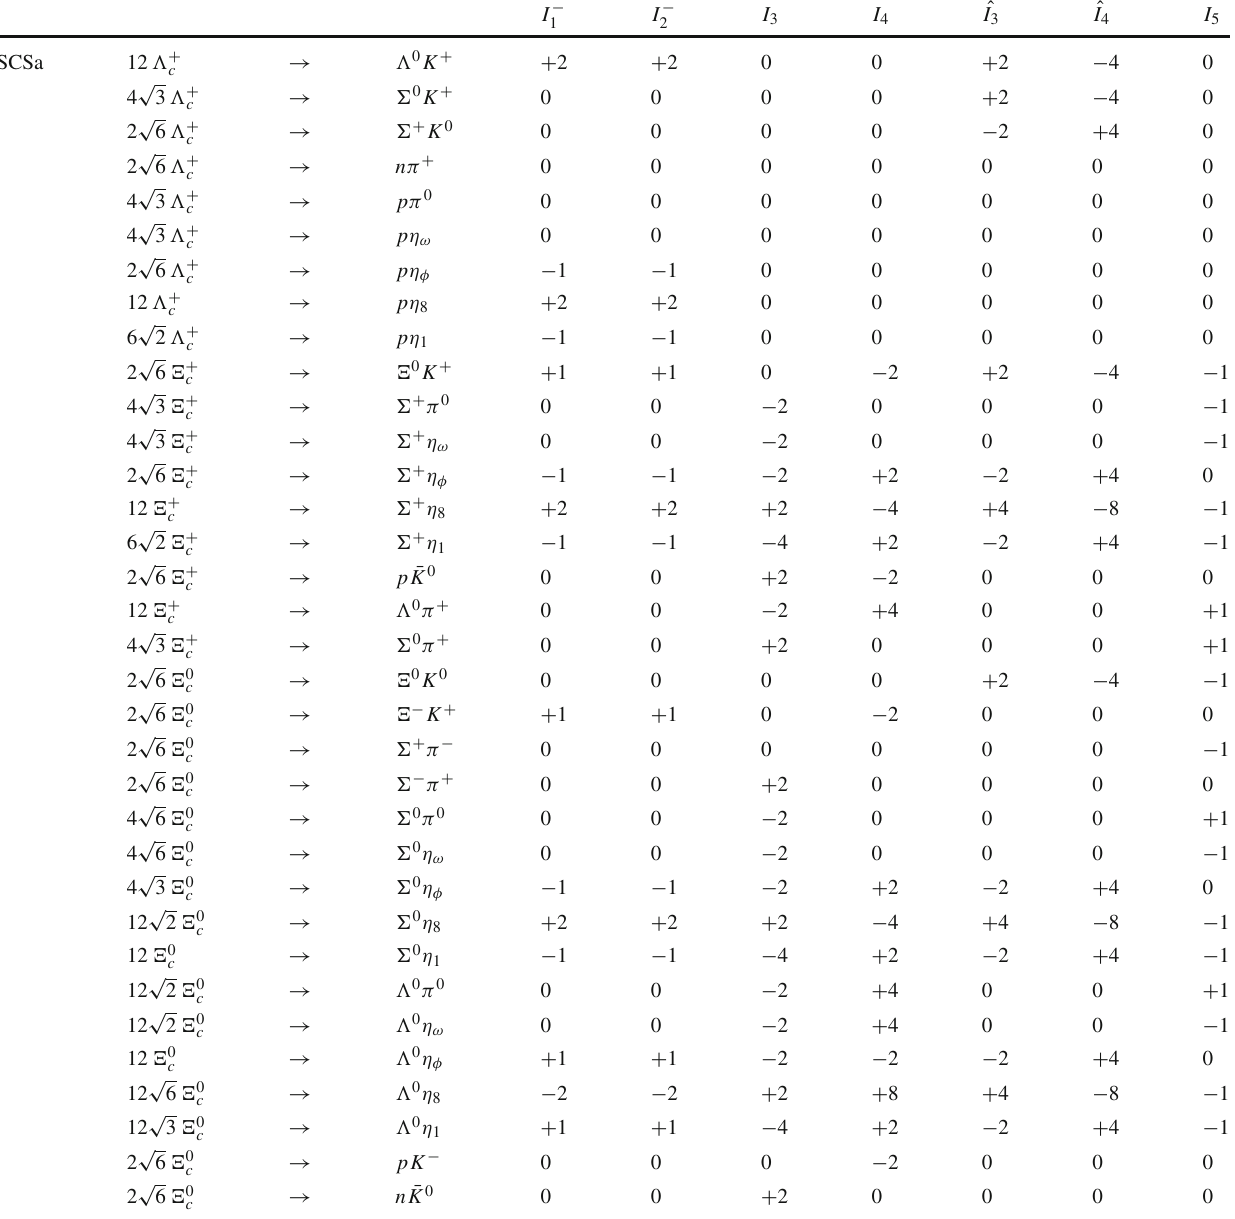
Table 4 Values of the seven topological tensor invariants for the SCS antitriplet charm baryon decays B c ( 3 ) → B ( 8 ) + M ( 8 , 1 ) induced by the flavor transition ( c → s ; s → u